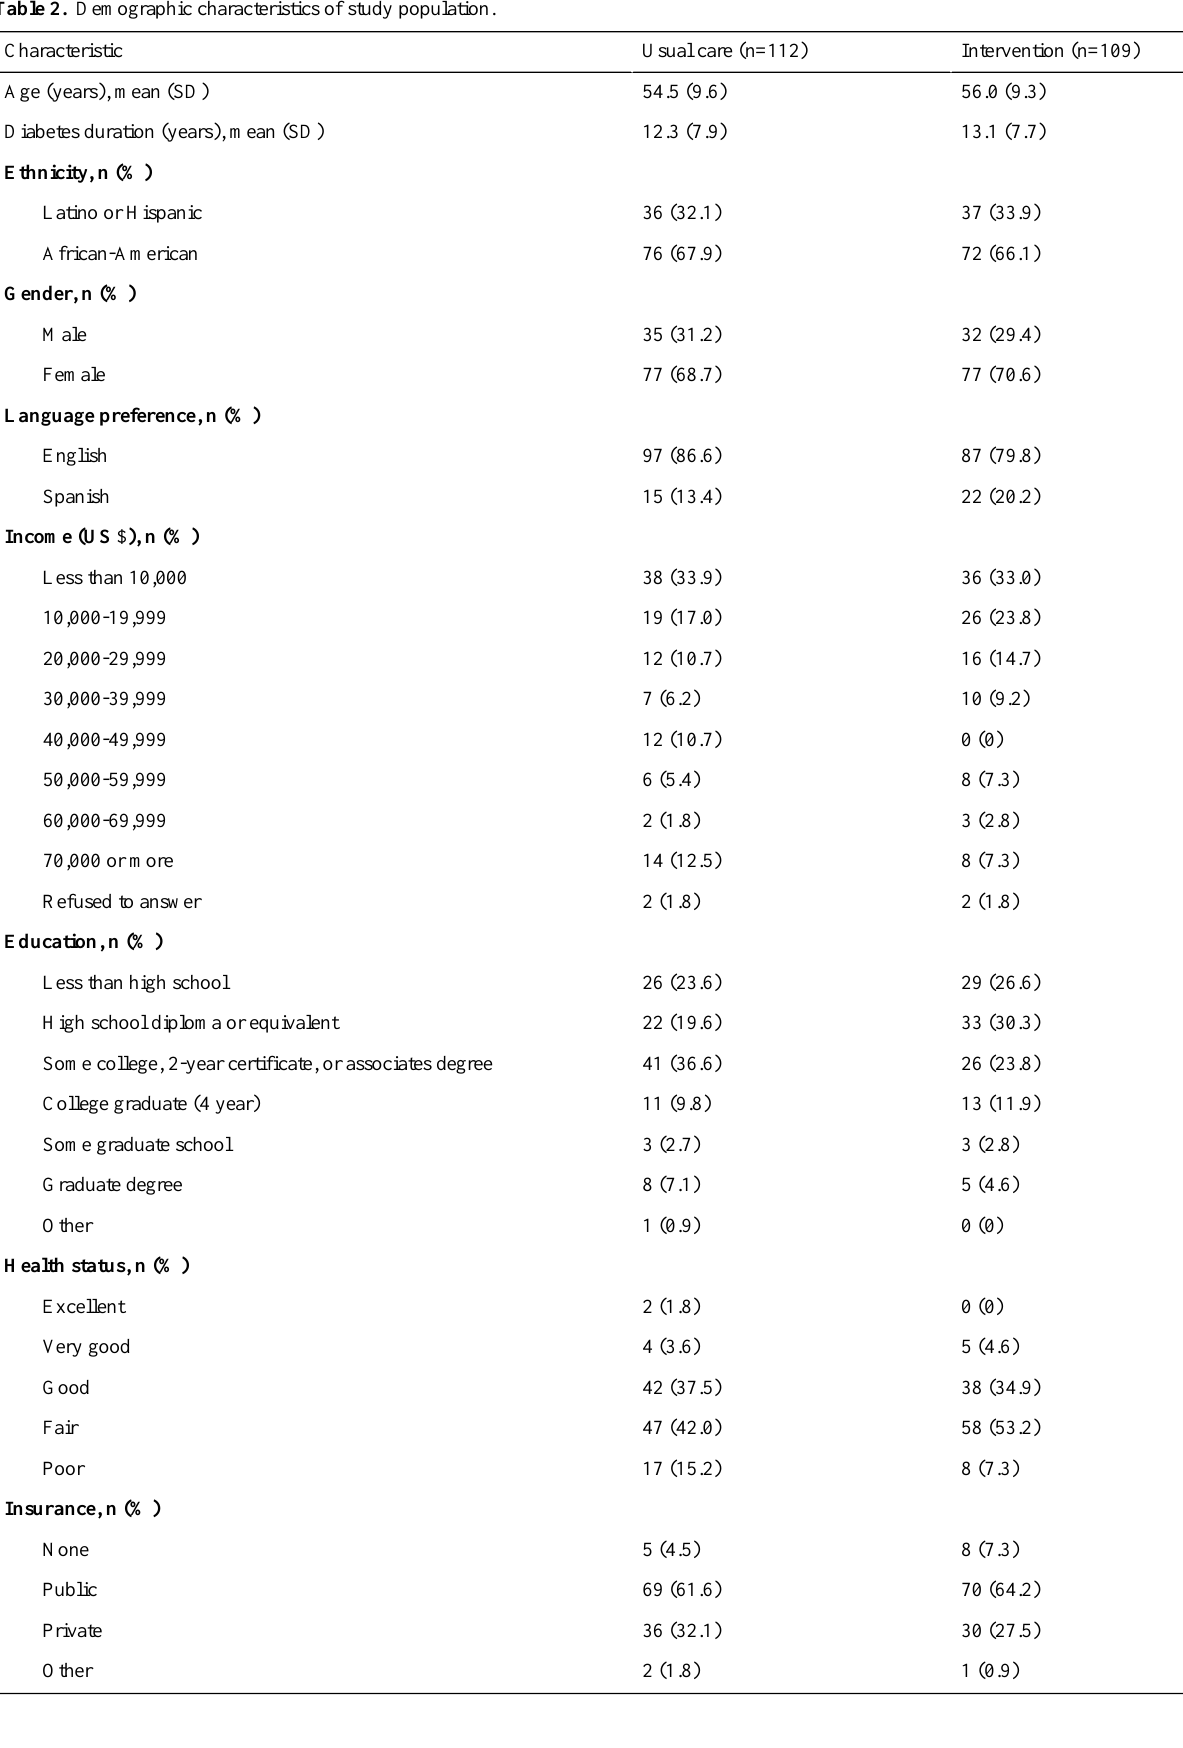
Table 2. Demographic characteristics of study population.